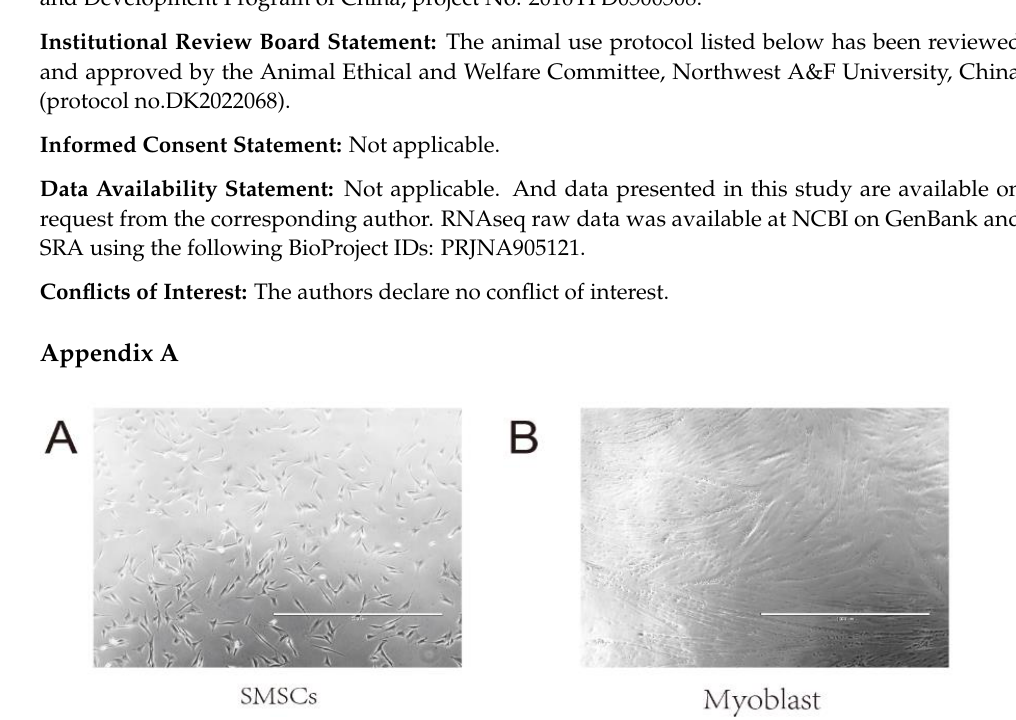
Figure A1. Myoblast differentiation. ( A ) SMSC morphology; ( B ) Myoblast morphology; (scale: 1 bar represents 400 µm).